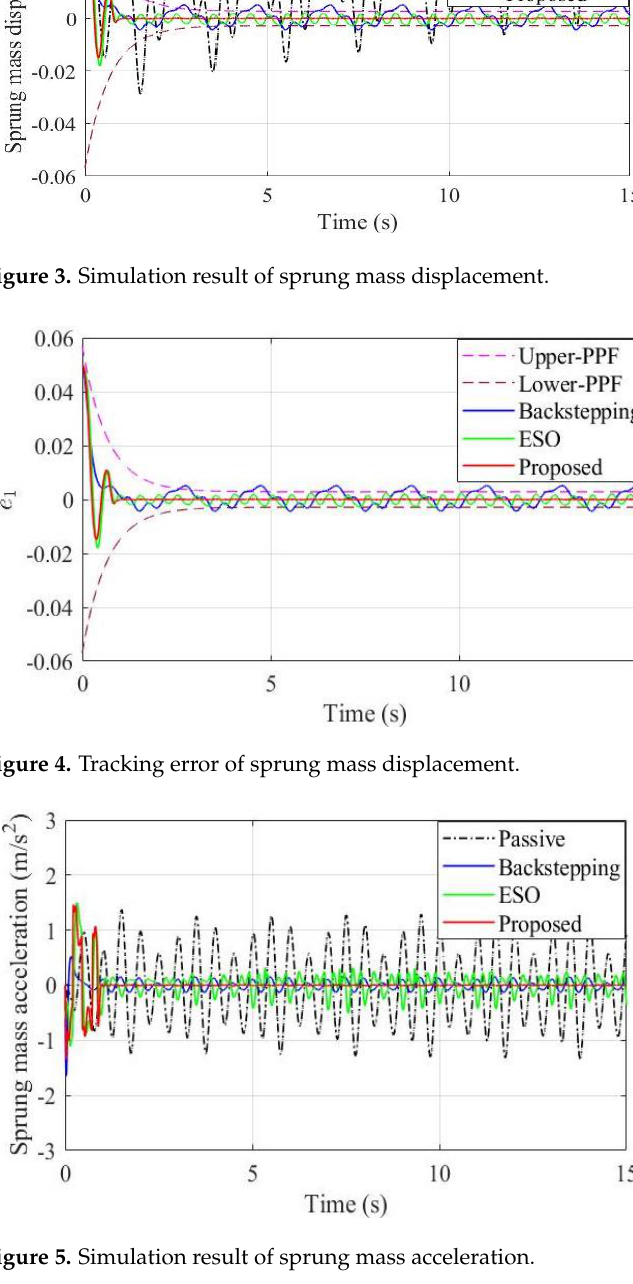
Figure 6. Relative suspension deflection. Figure 7. Relative tire force.